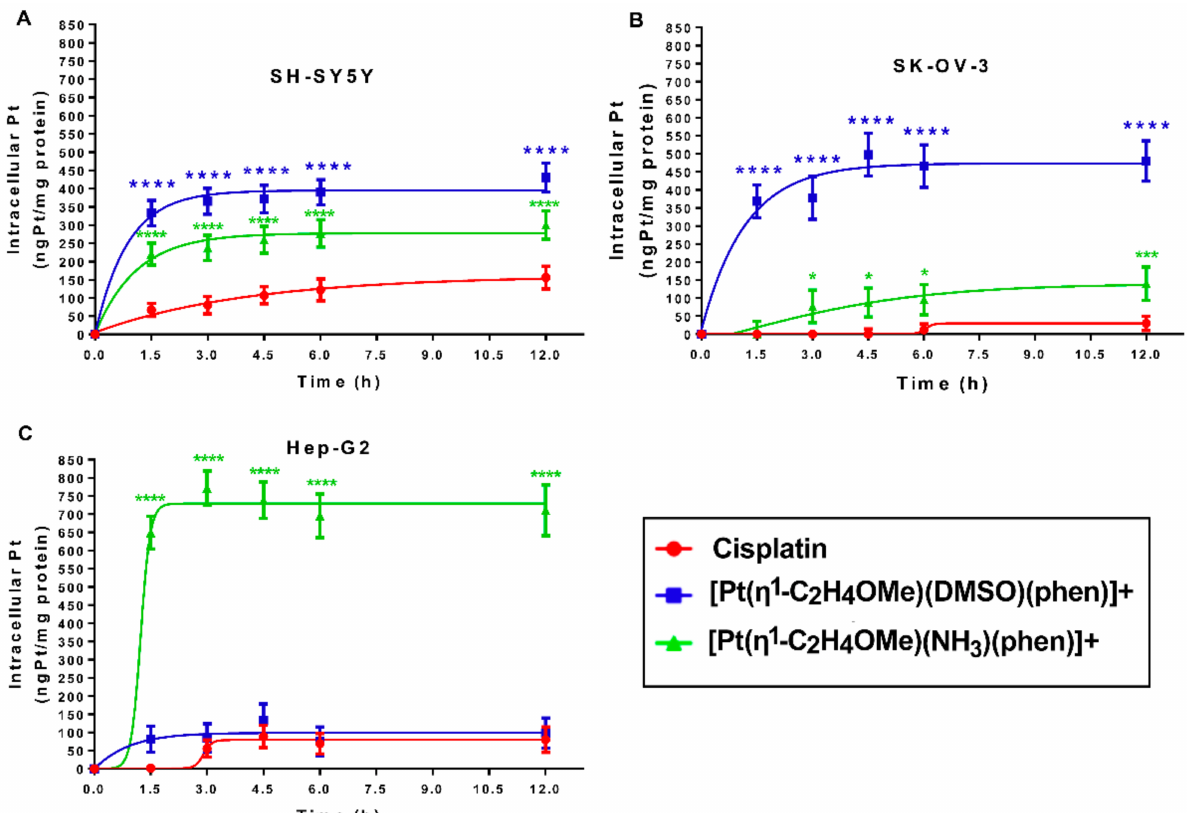
Figure 7. Intracellular uptake after [Pt( η 1 -C 2 H 4 OMe)(DMSO)(phen)] + , [Pt( η 1 -C 2 H 4 OMe)(NH 3 )(phen)] + , and cisplatin treatments in SH-SY5Y ( A ), SK-OV-3 ( B ) and Hep-G2 ( C ) cell lines. The total intracellular accumulation was determined by ICP-AES; cells were continuously exposed to 100 µ M of each Pt compound for 1.5–12 h. Each point represents the means ± S.D. of three different experiments and is indicated as ng of Pt(II)/mg of protein. Asterisks indicate values that are significantly different (* p < 0.05; *** p < 0.001; **** p < 0.0001) from those of cisplatin at the same concentration and time